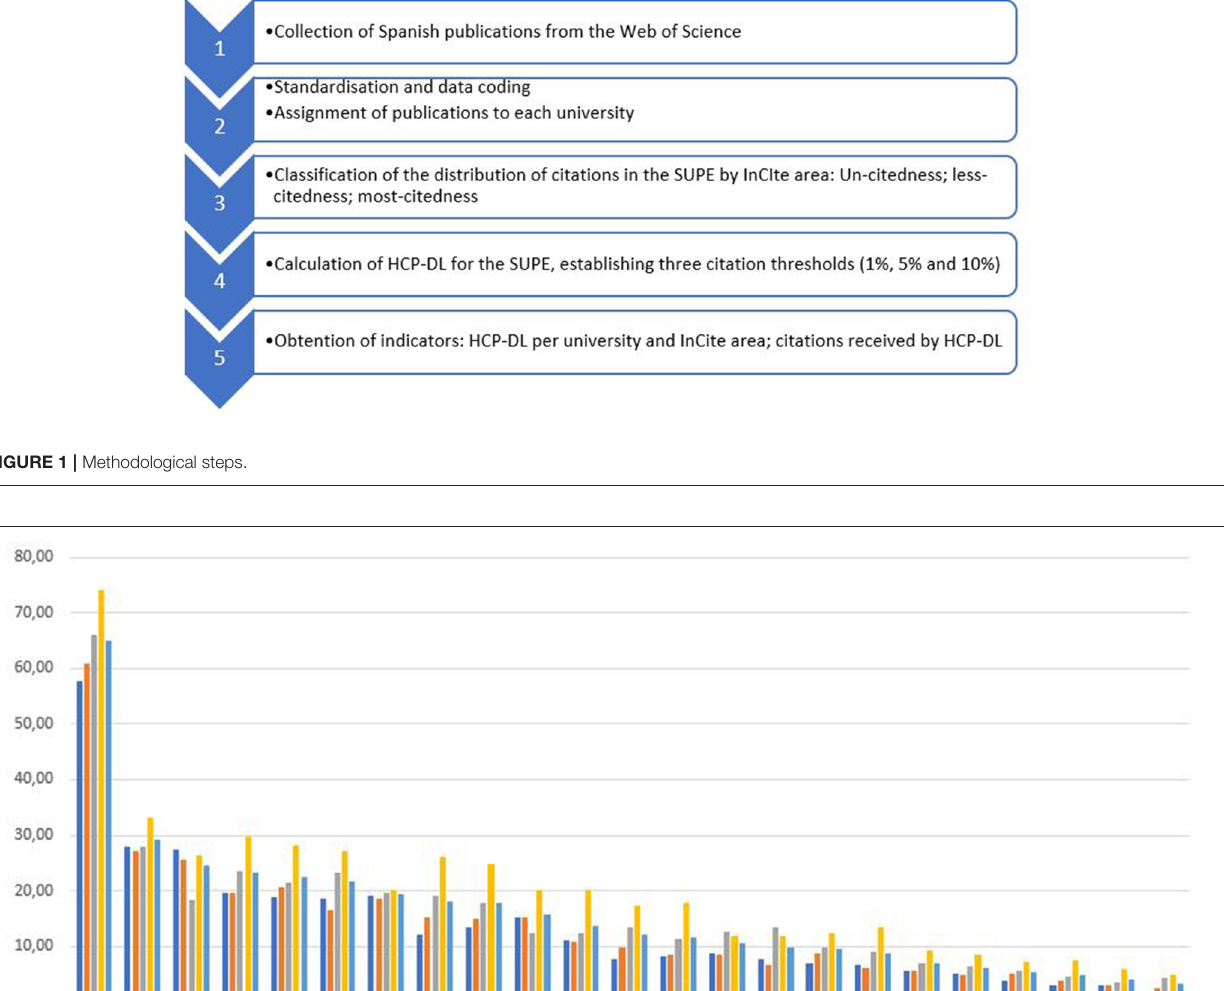
Frontiers in Research Metrics and Analytics |